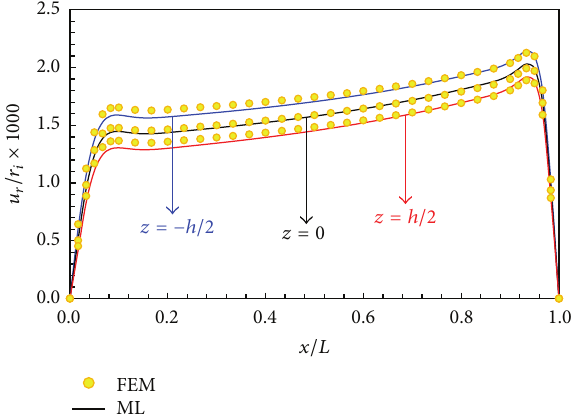
Figure 5: Radial displacement distribution in middle layer.